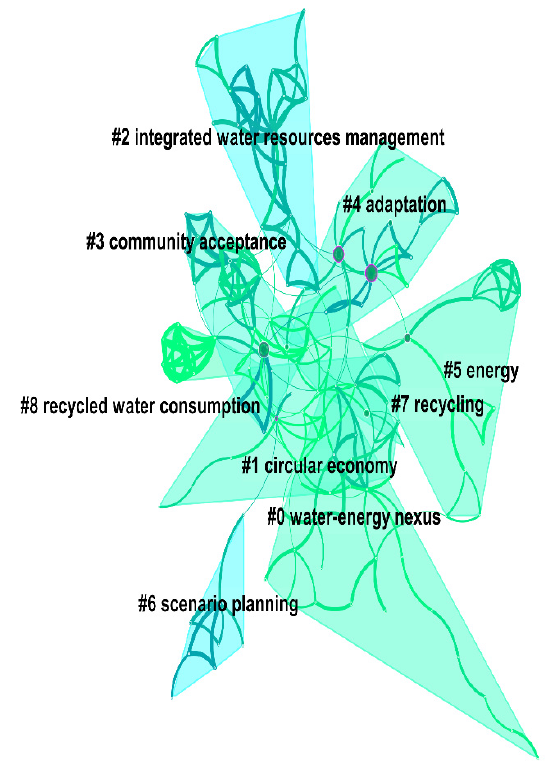
Figure 10. CNKI keyword clustering.